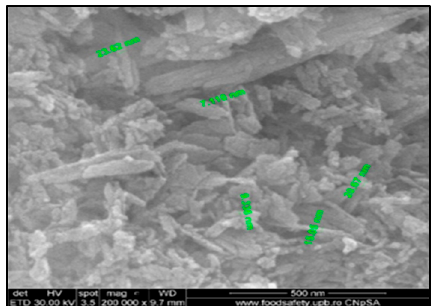
Figure 2. SEM image of HAp obtained from